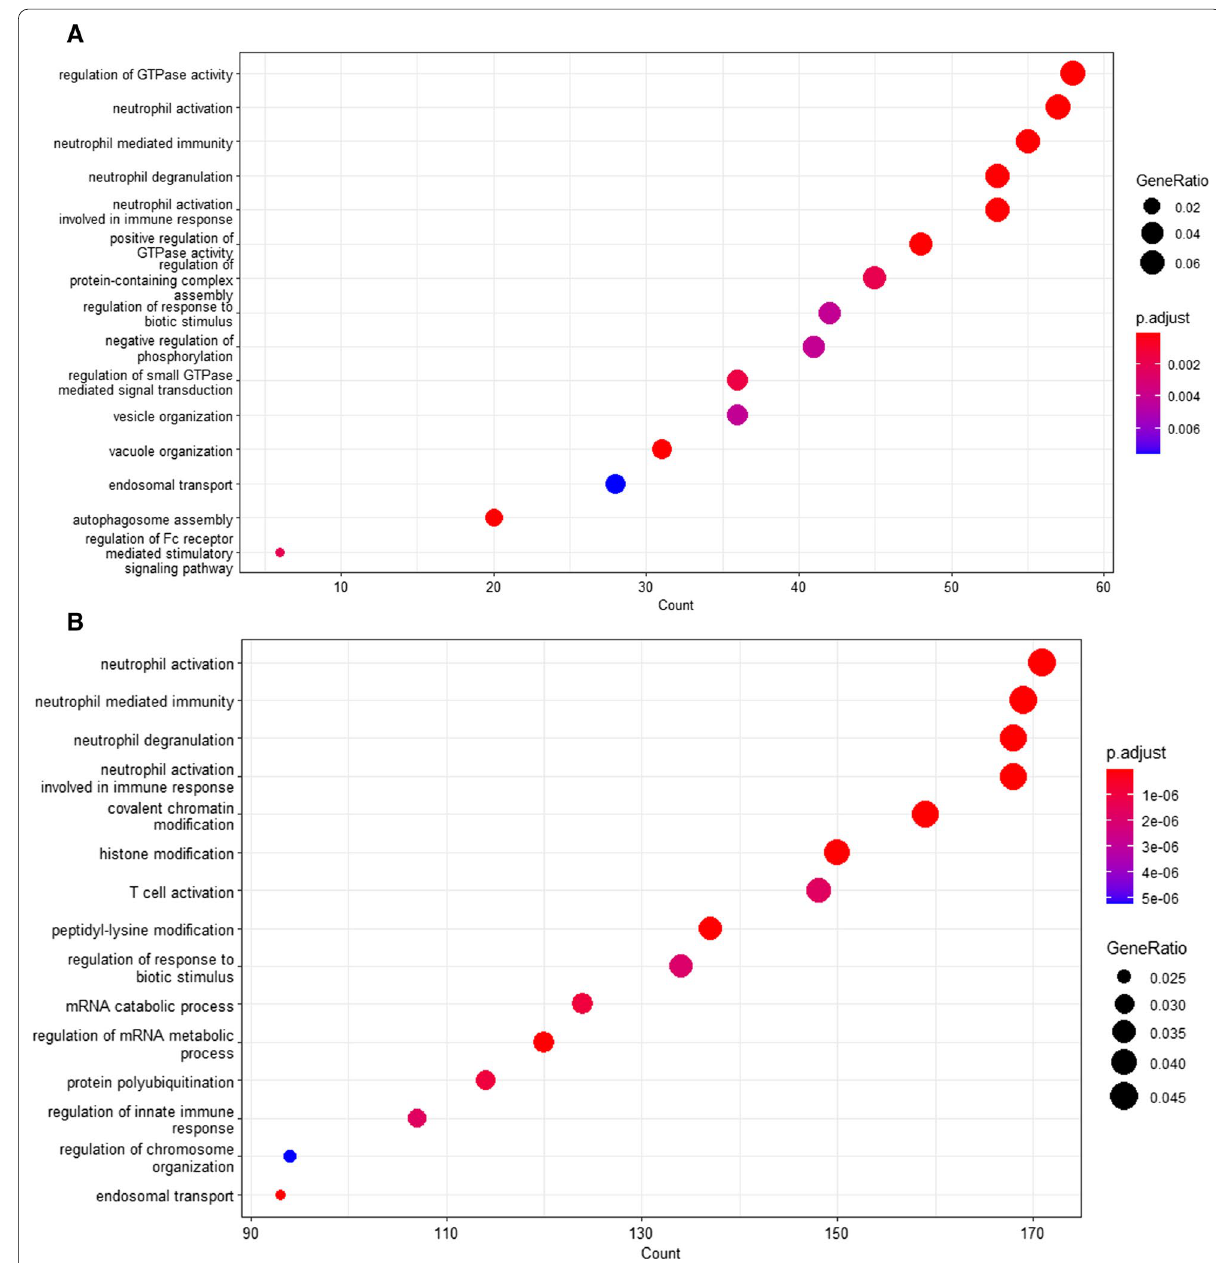
Fig. 4 Dot plot showing the top 15 enriched pathways. A Enriched pathways in critical patient cohorts, and B in non-critical patients’ cohorts. The color scale denotes the significance level, with “red” being more significant pathways and “blue” being downregulated pathways. The gene ratio shows the percentage of differentially expressed variants in each gene ontology